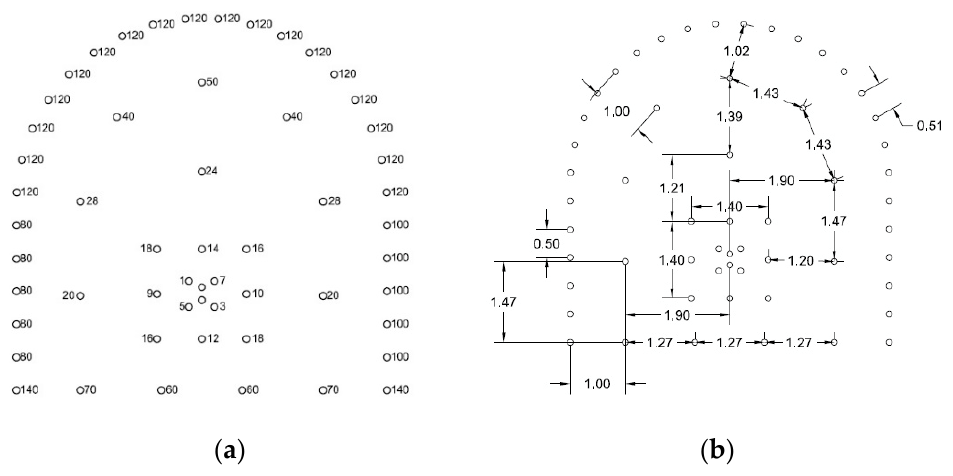
Figure 14. ( a , b ): Scheme of parallel holes cut. Pull: 2.5 m; surface: 30 m 2 ; total charge: 119 kg; detonating cord 40 g/m: 90 m; powder factor: 1.32 kg/m 3 ; holes’ diameter: 45 mm; delay time: 25 ms. ( a ) The numbers refer to the delay sequence; ( b ) quotes are expressed in meters [4].